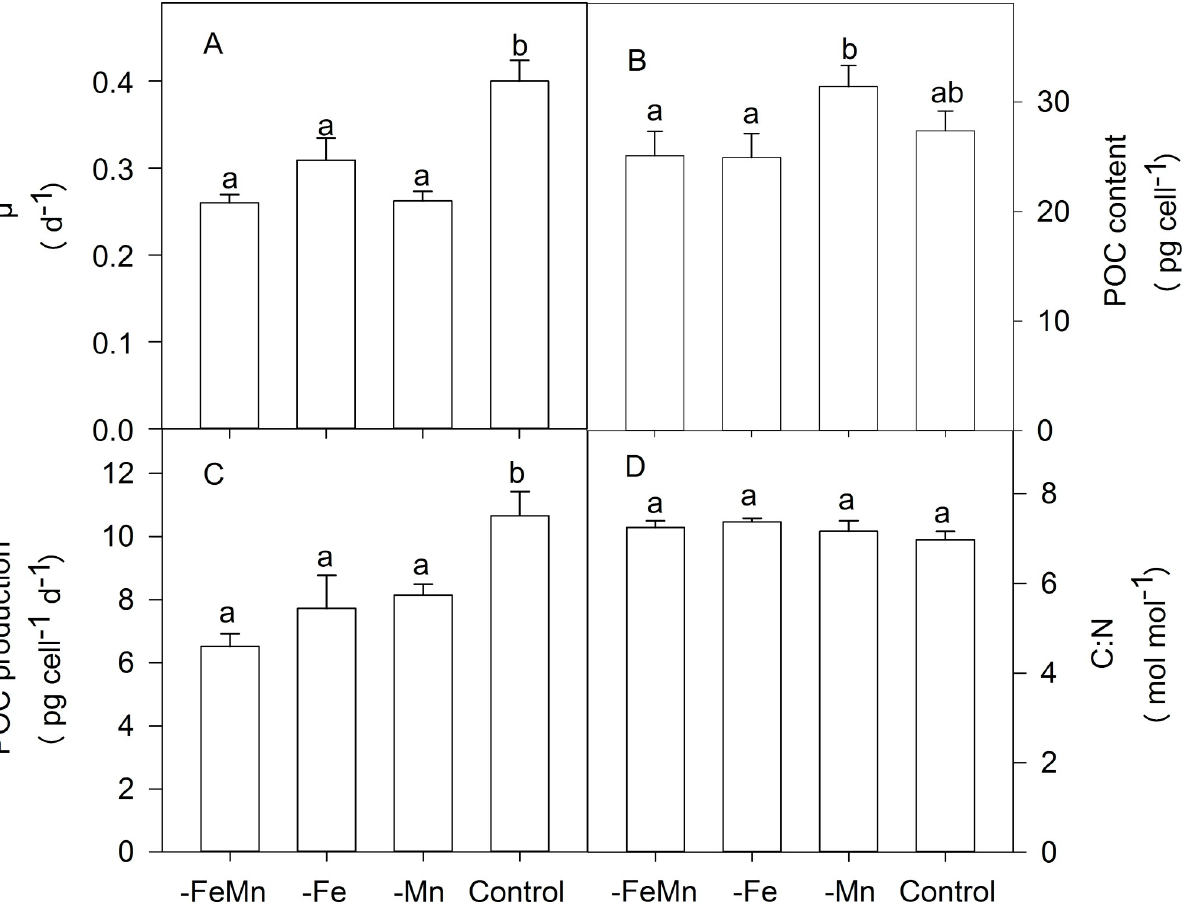
Fig 2. Growth rates (A), cellular production rate of particulate organic carbon (POC, B) and molar ratios of carbon to nitrogen (C:N, C) of C . debilis grown in naturally FeMn-poor Antarctic seawater (-FeMn) and to which additions of either Mn alone (-Fe), Fe alone (-Mn) or both (control) were given. Values represent the means ± SD (n = 3). Different letters indicate significant differences between treatments ( p < 0.05).